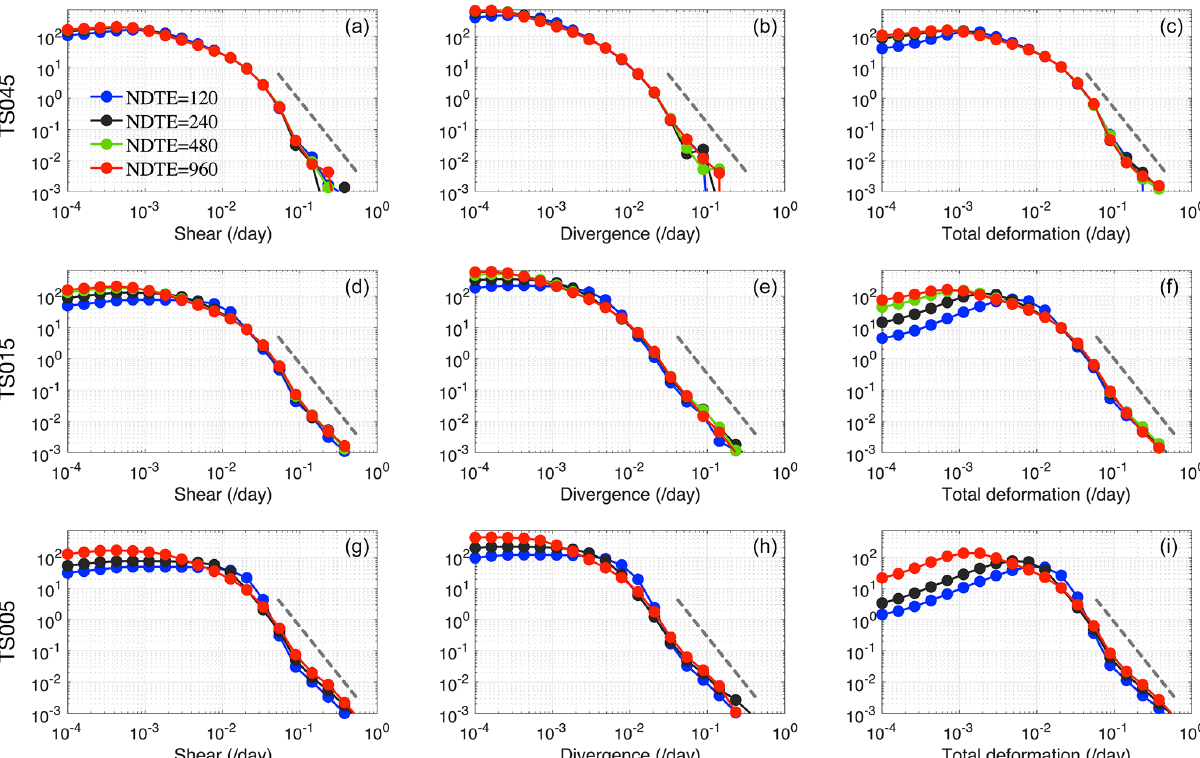
Figure 12. Probability density of modeled daily deformation rates during winter months (December to February) with TS045 (first row), TS015 (second row), and TS005 (third row). The region of study is outlined in Fig. 7. The shearing rate (left column), divergence rate (central column), and total deformation rate (right column) are shown. Runs with different EVP configurations (NDTE from 120 to 960) are marked by the same color as in Fig. 4a. The theoretical slope for the PDF tail of − 3 is shown in each panel for reference (grey dashed